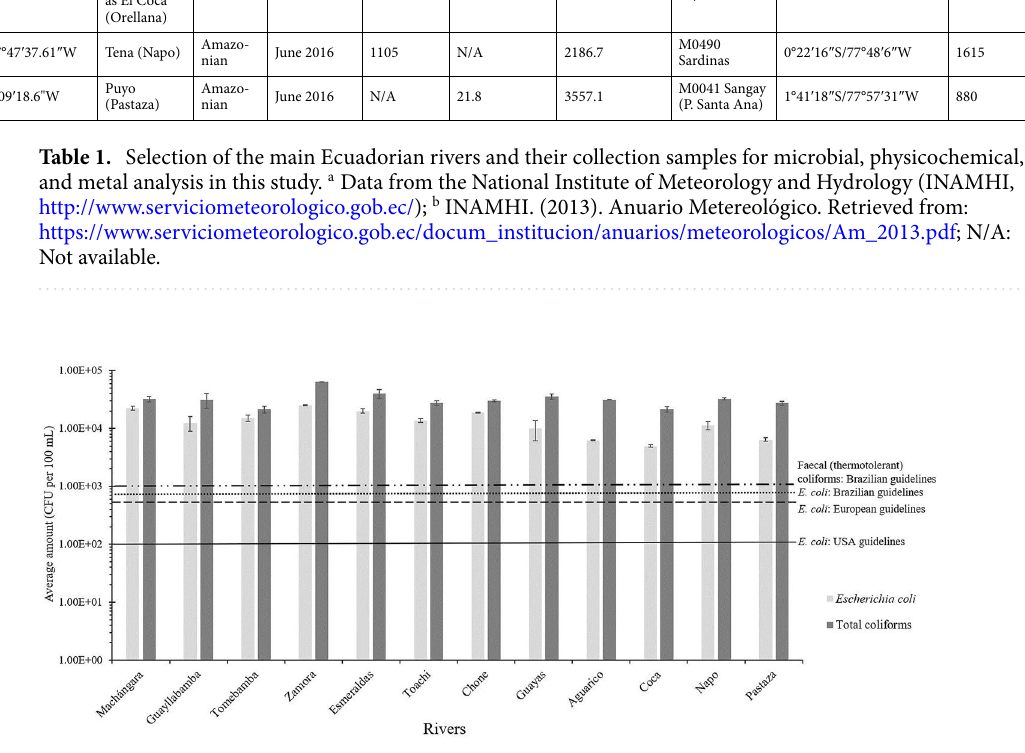
Figure 1. Average amount of Escherichia coli and total coliforms quantified in the rivers and their water classification accordingly to bathing-water standards by the USA, European and Brazilian guidelines. Legend: Threshold of faecal (thermotolerant) coliforms by Brazilian guidelines ( - -- - ); threshold of E. coli by Brazilian guidelines ( - - - ); threshold of E. coli by European guidelines (-- -- --); threshold of E. coli by USA guidelines